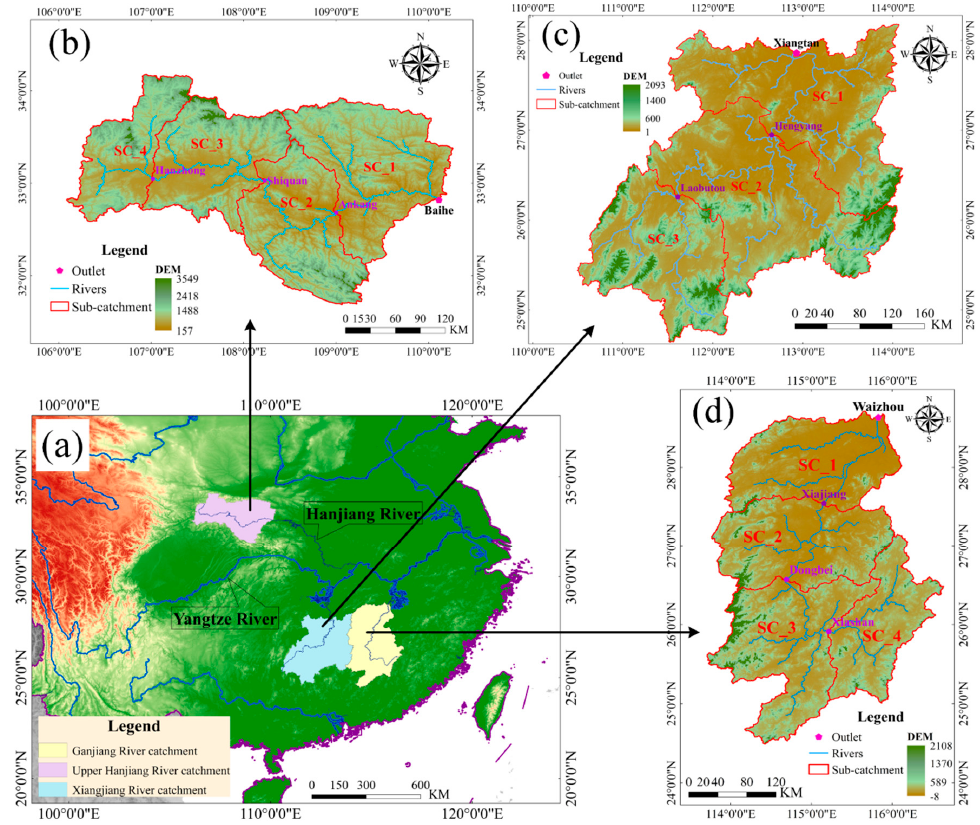
Figure 1. ( a ) Location, topography, and river systems of three study catchments and the hydrological stations selected for sub-catchments (SC). Sub-catchments are indicated by red lines. ( b ) The upper Hanjiang River catchment, ( c ) the Xiangjiang River catchment, and ( d ) the Ganjiang River catchment.